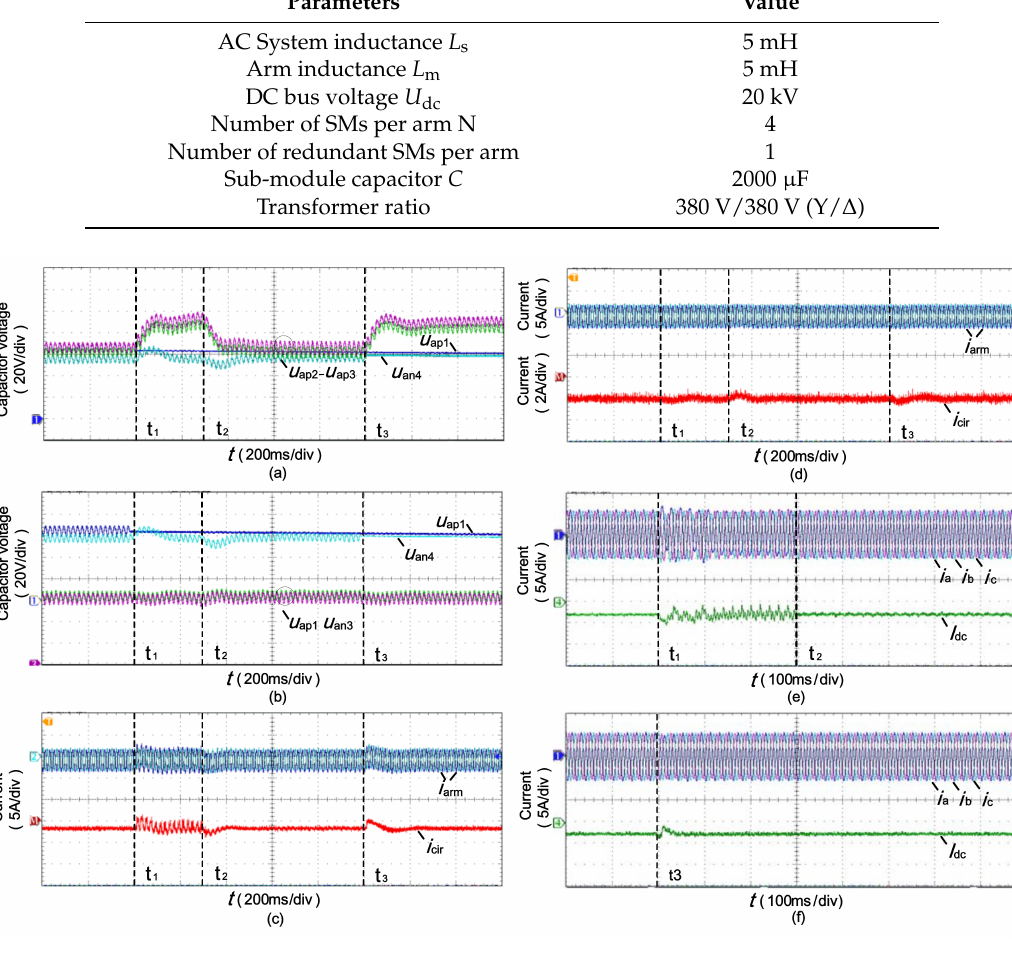
Figure 13. Waveforms of experiment: ( a ) Capacitor voltage of phase a; ( b ) Capacitor voltage of phase b; ( c ) Circulating current of phase a; ( d ) Circulating current of phase b; ( e ) AC current and DC current from t1 to t3; ( f ) AC current and DC current after